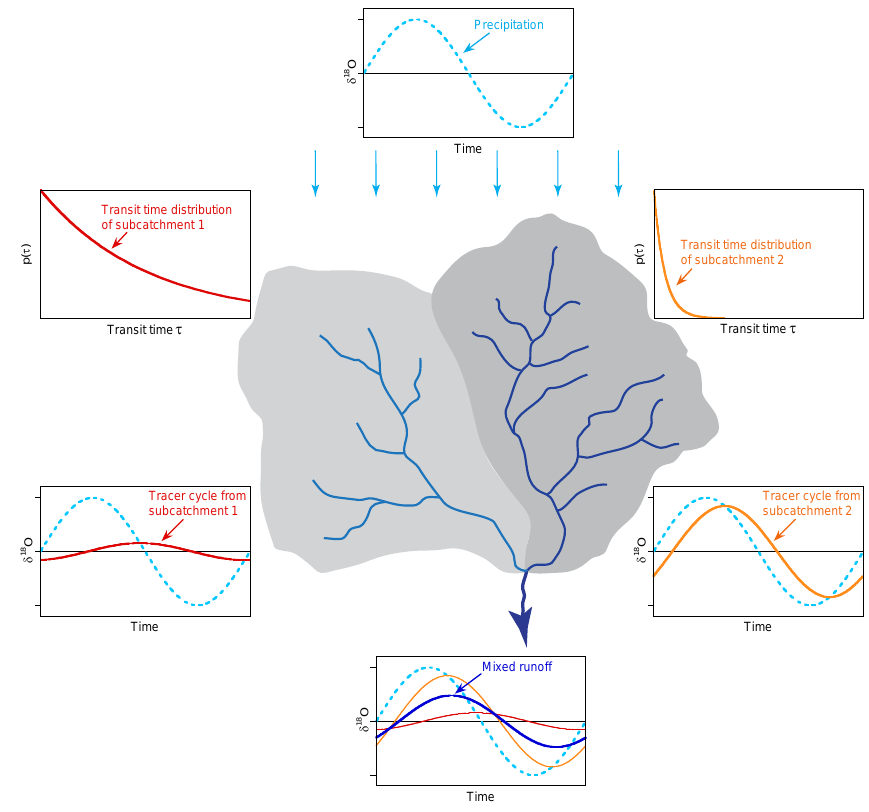
Figure 4. Conceptual diagram illustrating the mixture of seasonal tracer cycles in runoff from a heterogeneous catchment, comprising two subcatchments with strongly contrasting MTTs, and which thus damp the tracer cycle in precipitation (light blue dashed line) by different amounts. The tracer cycle in the combined runoff from the two subcatchments (dark blue solid line) will average together the highly damped cycle from subcatchment 1, with long MTT (solid red line), and the less damped cycle from subcatchment 2, with short MTT (solid orange